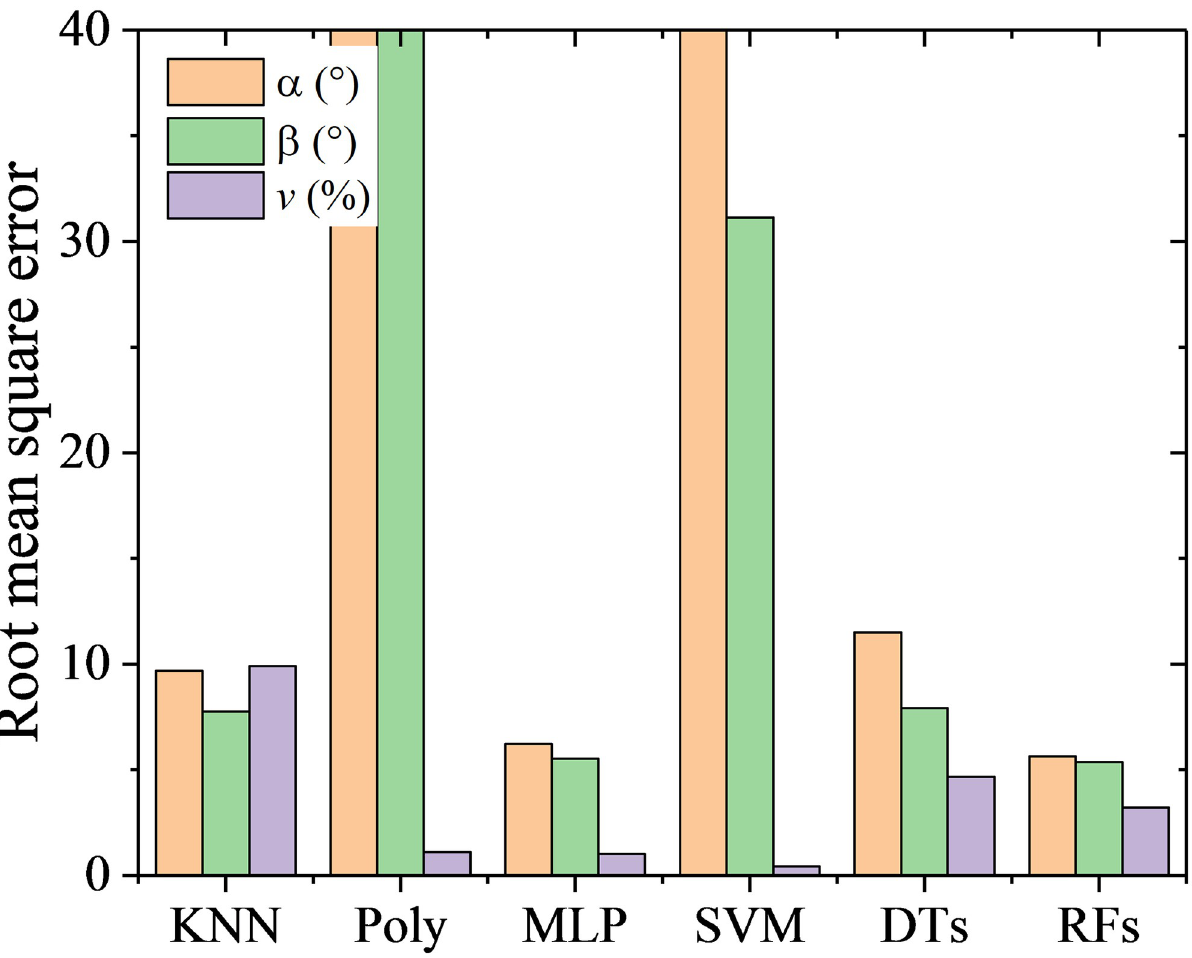
Fig 21. RMSEs using feature in Eq (4). https://doi.org/10.1371/journal.pone.0277672.g021 PLOS ONE | https://doi.org/10.1371/journal.pone.0277672 January 23,